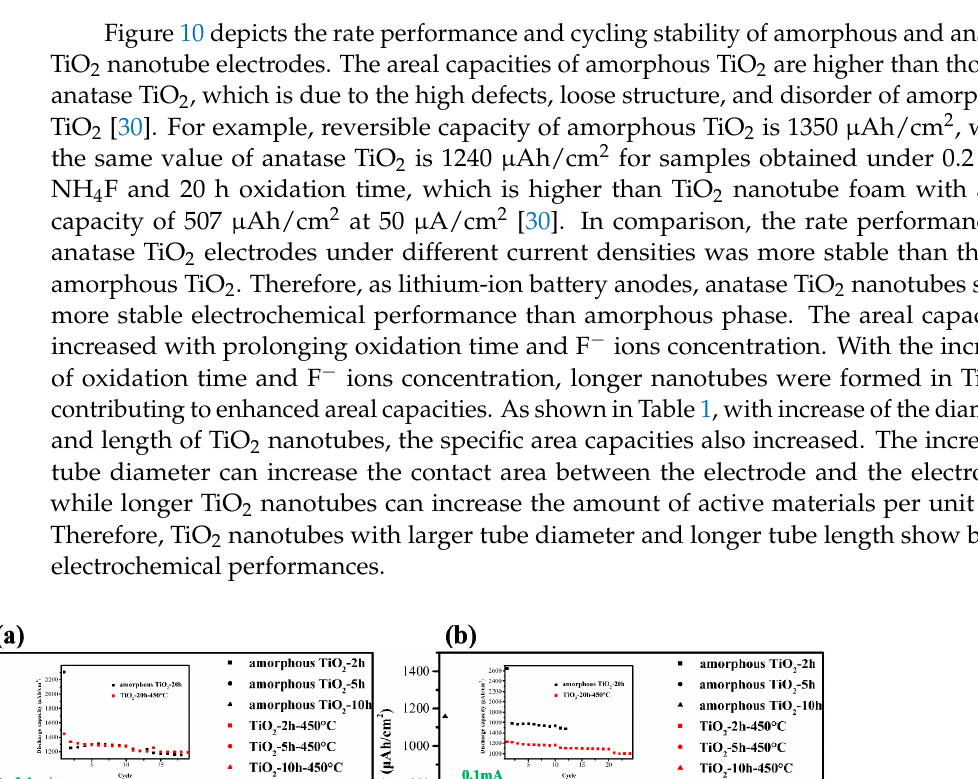
Figure 9. Nyquist plots of amorphous TiO 2 -20 h and anatase TiO 2 -20 h-450 ◦ C anodes under different oxidation times: ( a ) 2 h; ( b ) 5 h; ( c ) 10 h; ( d ) 20 h. The samples were synthesized in electrolyte with 0.5 wt% NH 4 F and anodization time of 20 h.